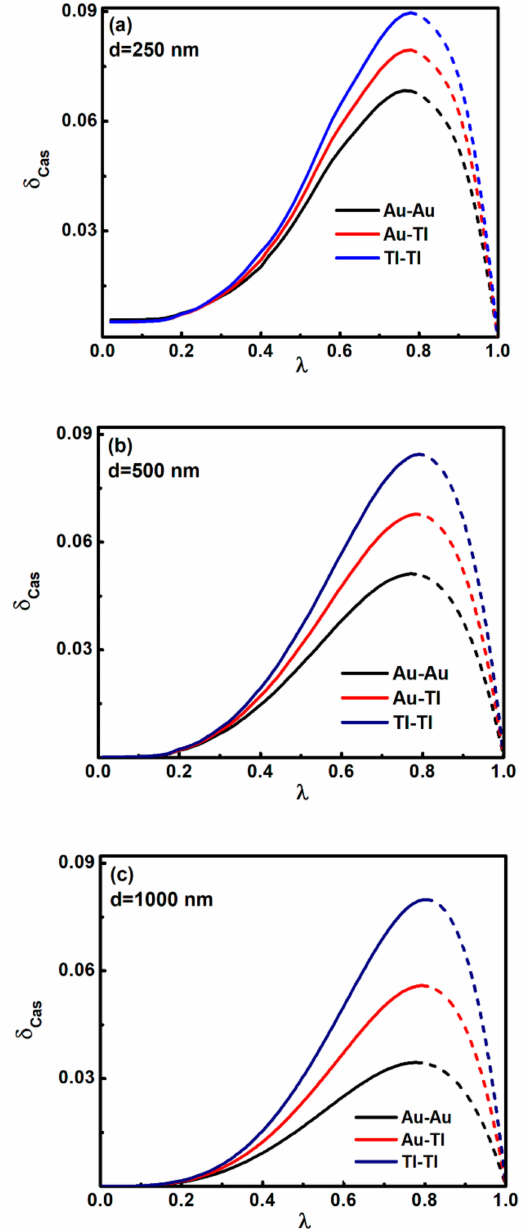
Figure 2. Bifurcation diagrams δ Cas vs. λ (=z/d) for different interacting materials. The initial distance d between the plates is ( a ) 250 nm, ( b ) 500 nm, and ( c ) 1000 nm. The dashed and solid lines represent the unstable and stable equilibrium points,